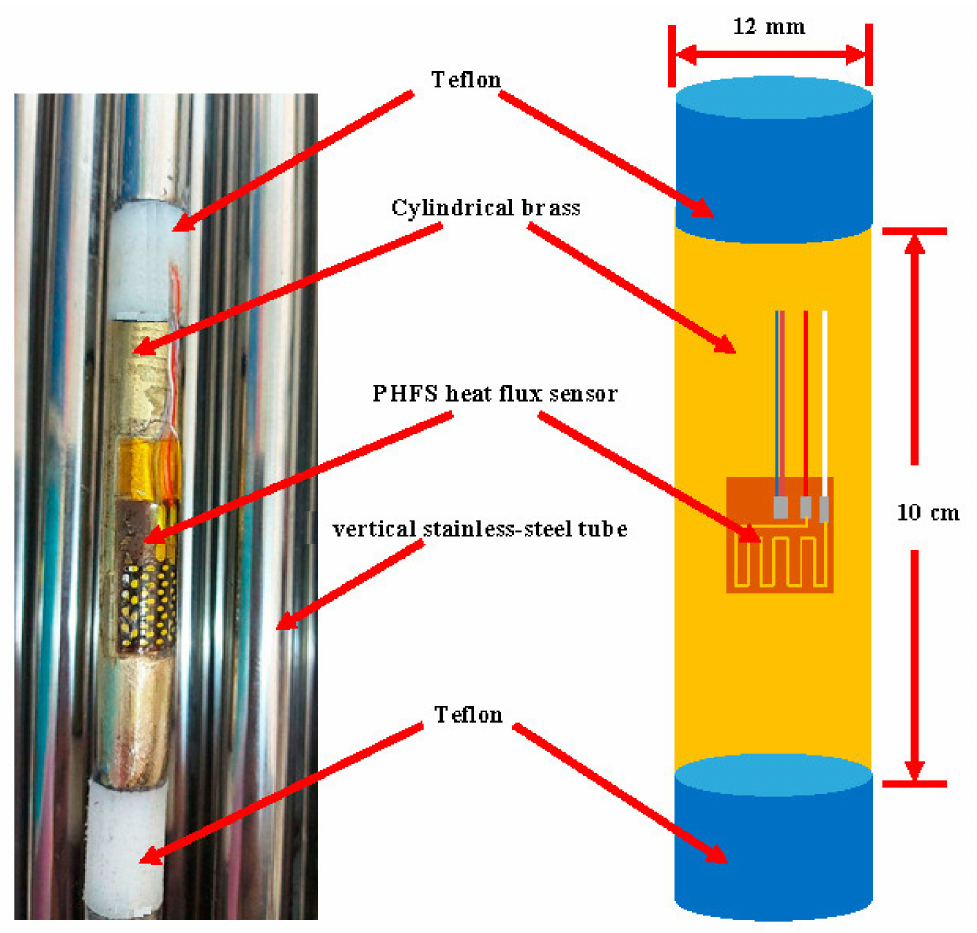
Figure 3. Illustration and photo of heat transfer